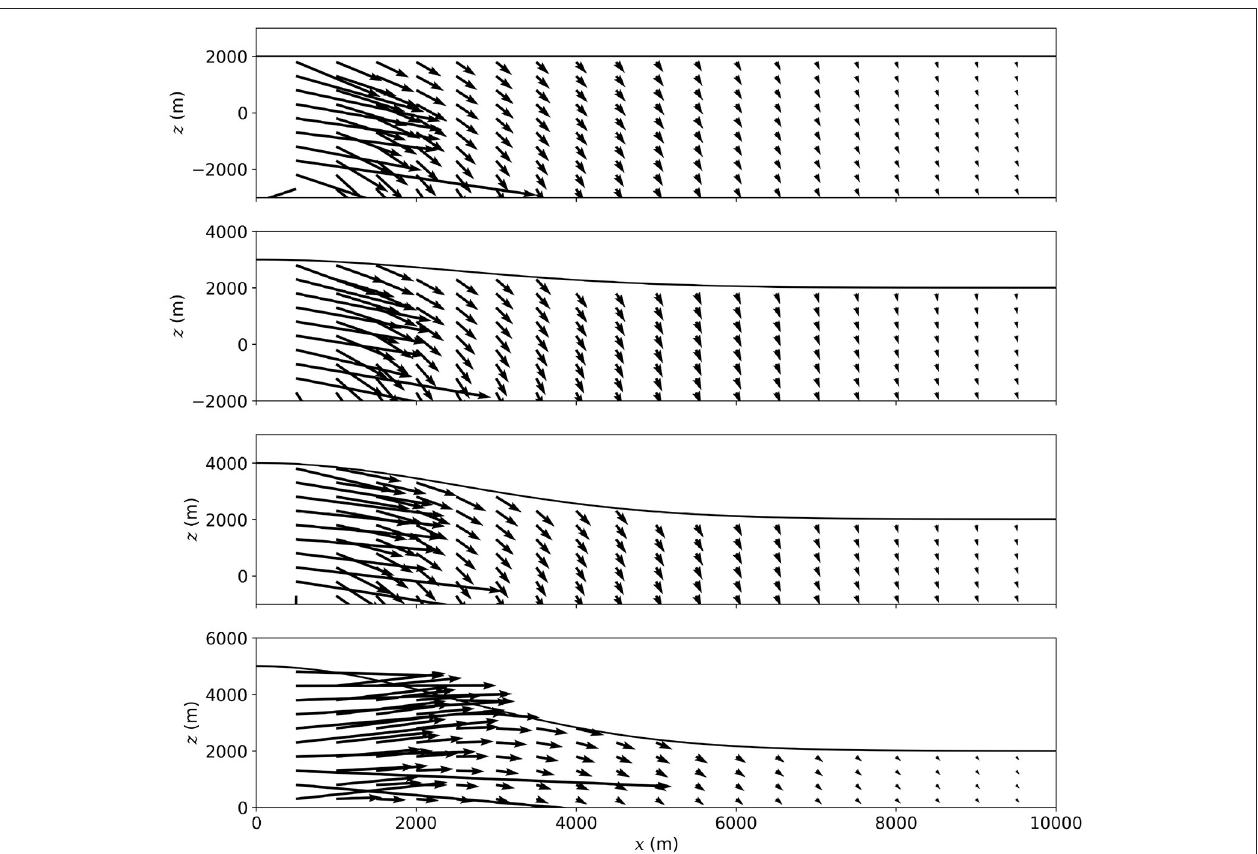
FIGURE 3 | Deformation field produced by overpressure of the conduit for a suite of values for the edifice relief. In each case the pressure source extends from the surface to 5 km below. The arrows depict the amplitude and orientation of the displacement field at each point.